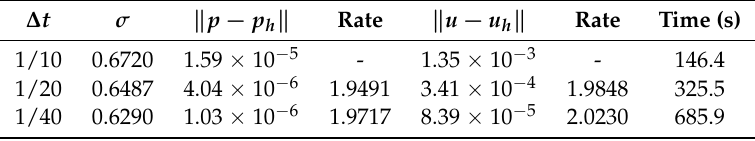
and h = 1 . 500 500